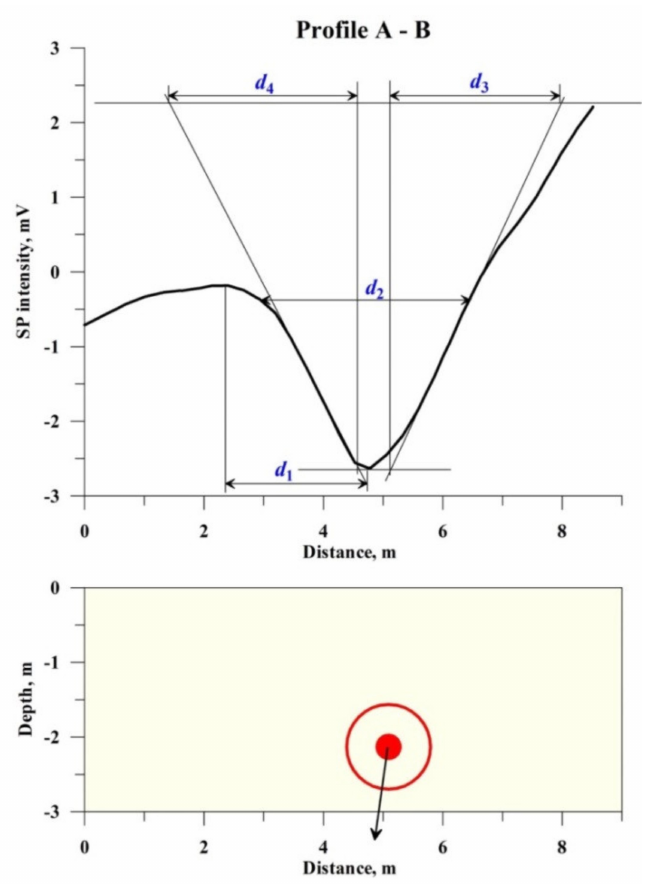
Figure 16. Quantitative analysis of self-potential anomaly along profile A–B in the site of Emmaus- Nikopolis (SP map is presented in Figure 15). The black arrow shows the direction of self- polarization